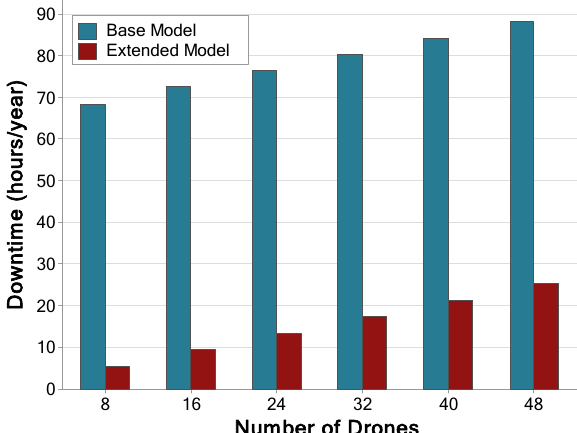
Figure 13. Inactivity in relation to the number of UAVs.